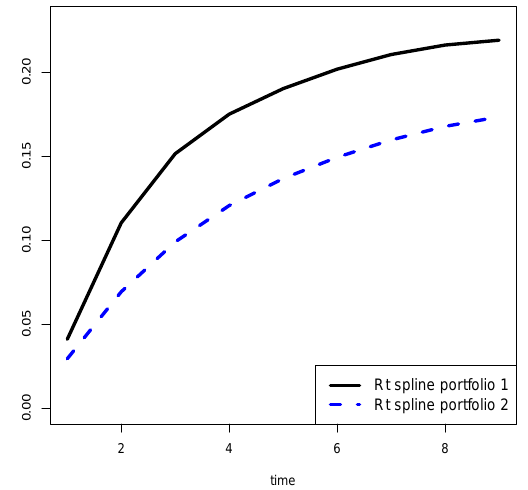
Figure 11. Comparison of recovery curve in term of R t for portfolio 1 and portfolio 2.